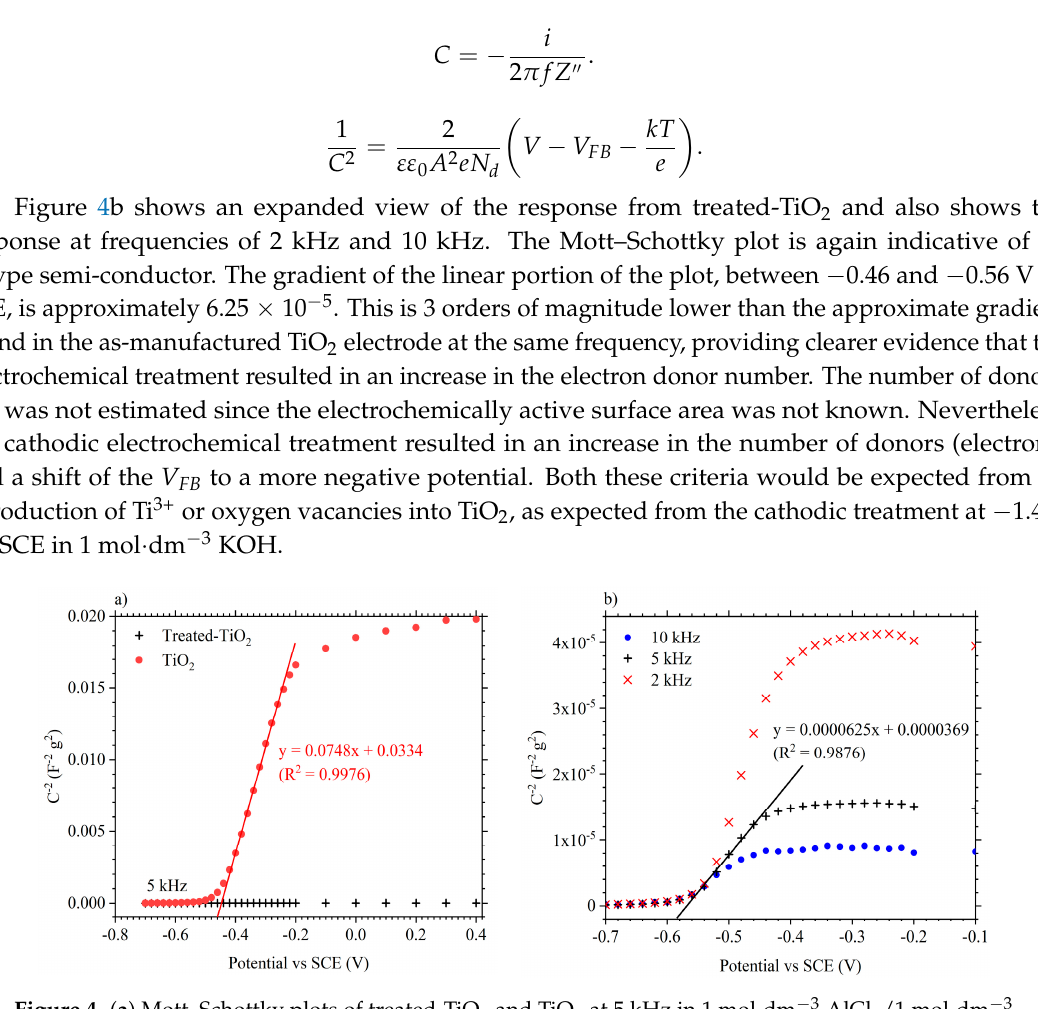
Figure 4. ( a ) Mott–Schottky plots of treated-TiO 2 and TiO 2 at 5 kHz in 1 mol·dm − 3 AlCl 3 /1 mol·dm − 3 KCl; ( b ) Mott–Schottky plots of the treated TiO 2 electrode at 2, 5 and 10 kHz.